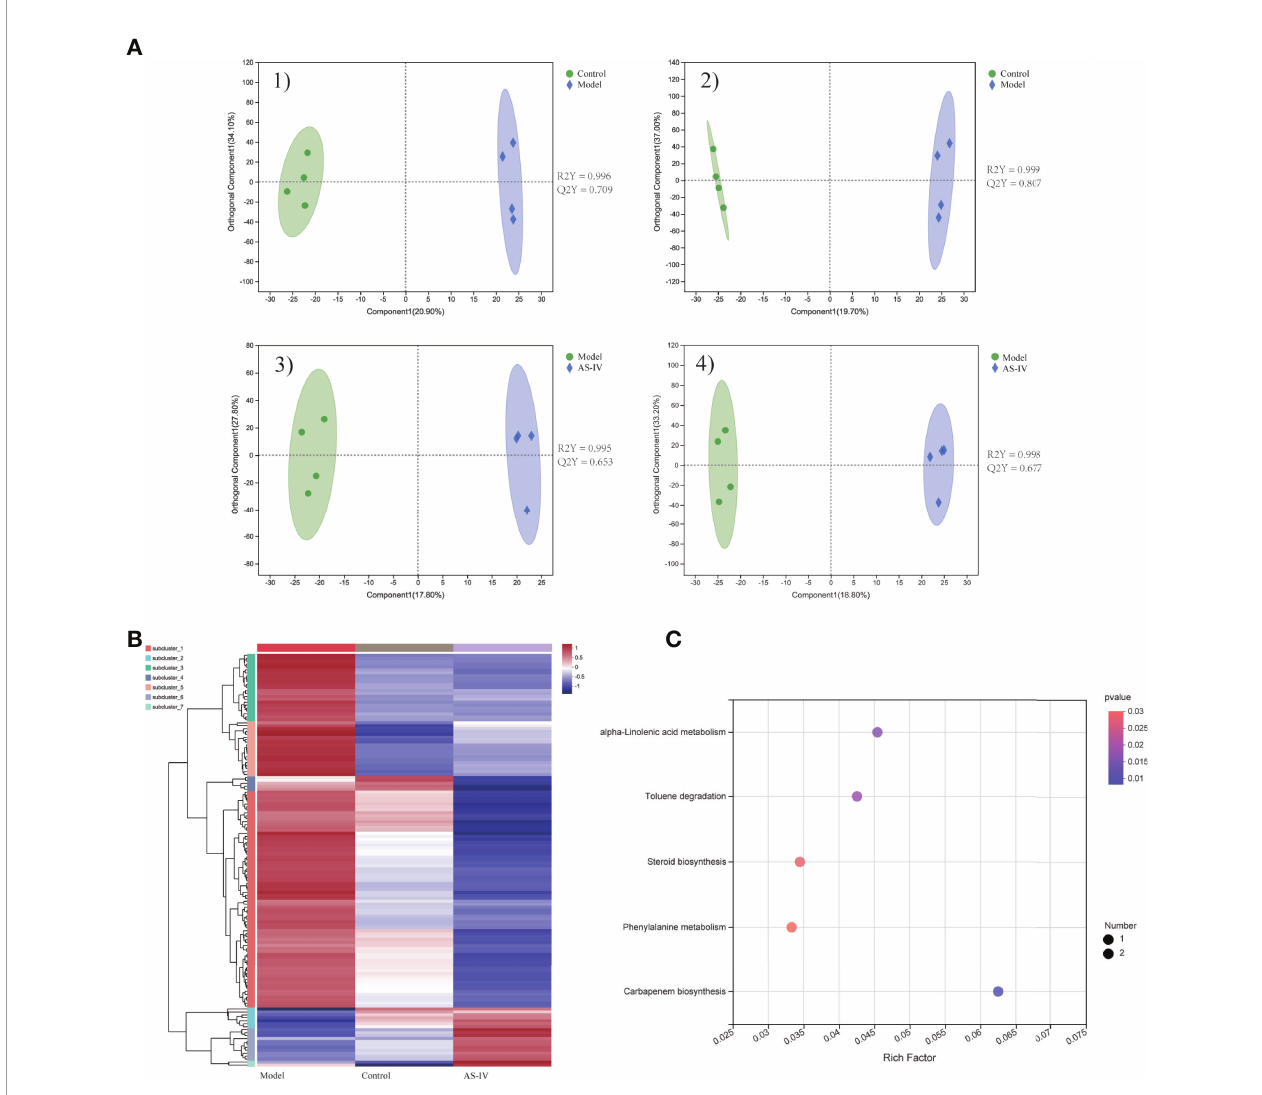
FIGURE 6 | Metabolic pro fi les of feces samples in cardiac fi brosis mice treated by AS-IV. (A) 1,2) OPLS-DA plot of control and model groups in positive and negative mode; 3,4) OPLS-DA plot of model and AS-IV groups in positive and negative mode. (B) Heatmap of 141 signi fi cantly different metabolites. (C) Metabolic- pathway enrichment